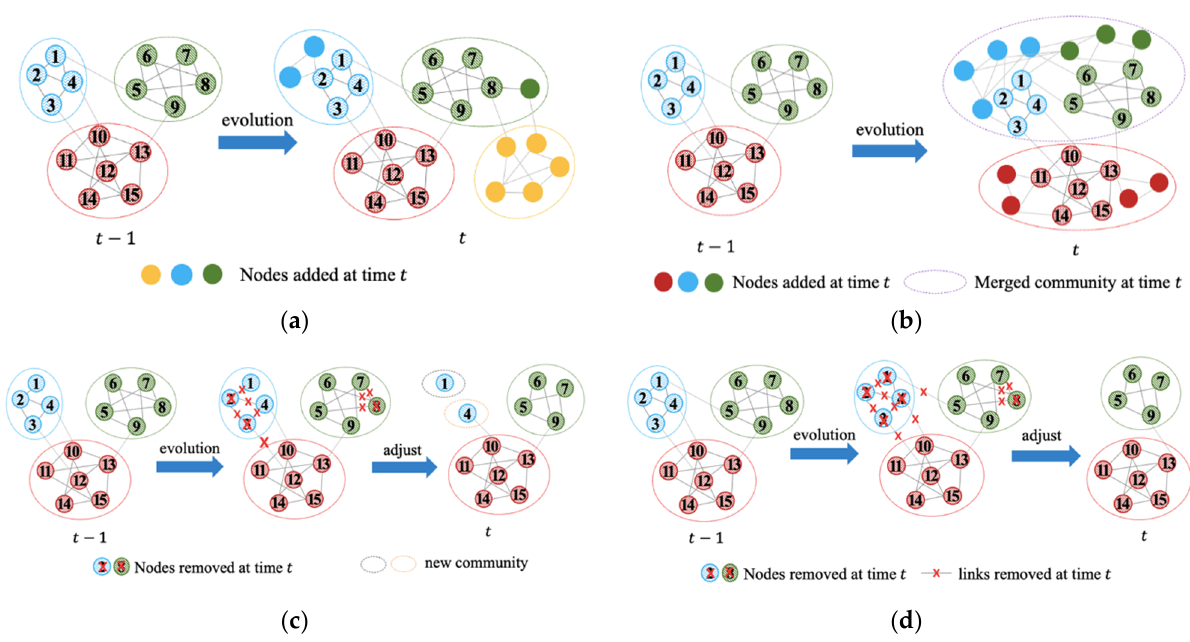
Figure 5. Schematic diagram of dynamic network evolution when | C | changes. ( a ) | C | increases after adding nodes; ( b ) | C | decreases after adding nodes; ( c ) | C | increases after deleting nodes; ( d ) | C | decreases after deleting